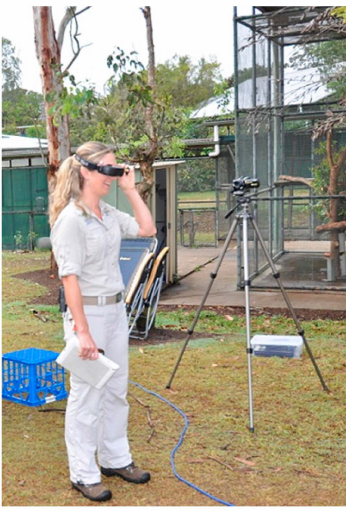
Figure 3. Wildlife expert using FPV goggles to observe wildlife while the UAV is flying above the canopy.